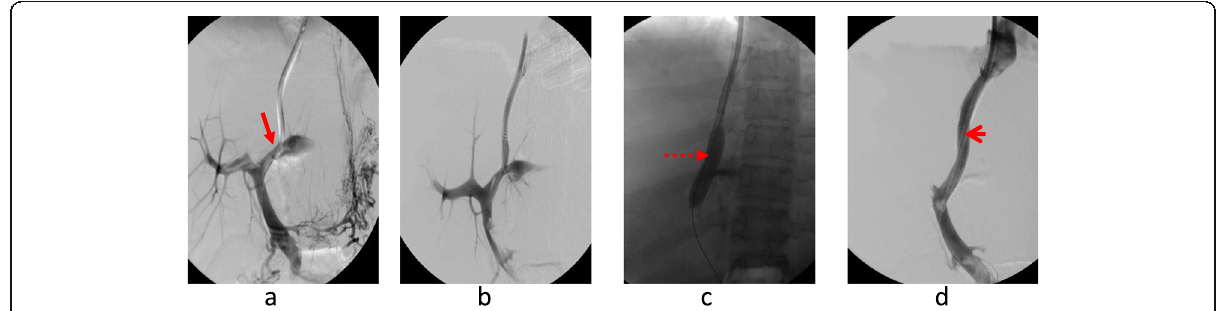
Fig. 4 A TIPS through the LPV in a male patient with ascites and varices. The puncture needle (arrow) inside the left portal branch ( a ). Subsequently, the catheter was introduced inside the main portal ( b ) with portography. Balloon (interrupted arrow) was introduced to dilate the stent ( c ) between the left portal and cava. The stent after dilatation (arrowhead) shows a straight course with an excellent flow ( d